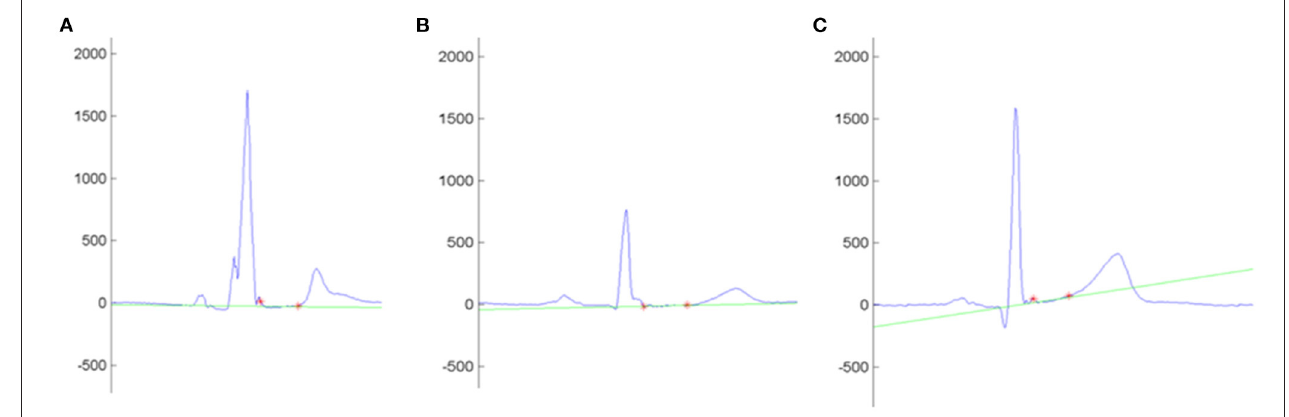
FIGURE 3 | Example of the automatic measurement of the ST slope in the lead I. Y-Axis shows the voltage (mV). Red asterisks mark the QRS offset and the T-wave onset. The intersection line (green) determines the ST-slope angle with the isoelectric line. (A–C) shows the ST slope of an arrhythmogenic cardiomyopathy patient ( − 0.4 ◦ ), a non-affected mutation carrier (1.9 ◦ ), and a control (9.3 ◦ ),